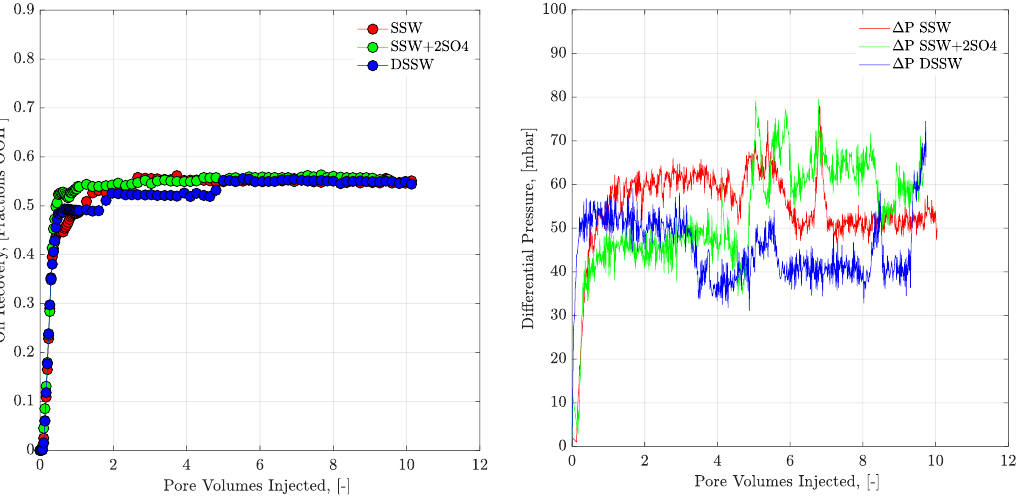
Figure 17. Oil recovery and pressure drop versus PV injected for water-wet real structure micromodel. Three injection brines of Table 2 are flooded as the secondary mode.